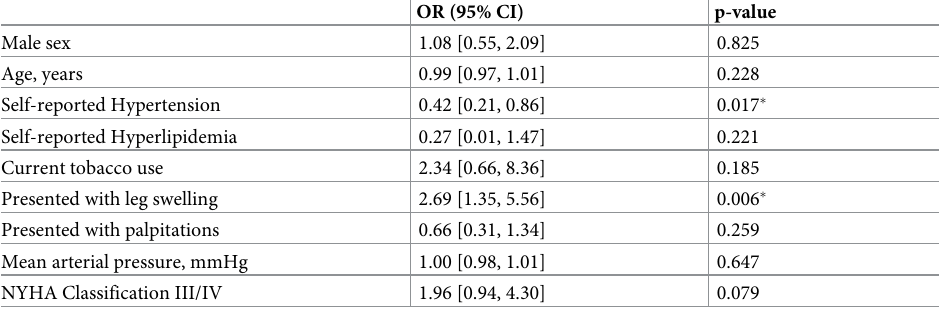
Table 5. Multivariate predictors of thirty-day mortality following hospital diagnosis of heart failure, northern Tanzania (n =